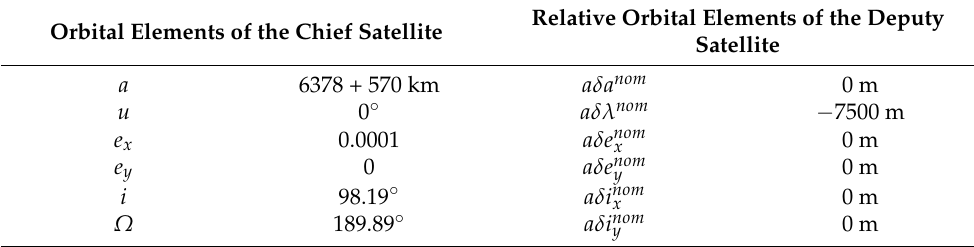
Table 3. Orbital elements of the chief satellite and relative orbital elements of the deputy satellite. Orbital Elements of the Chief Satellite